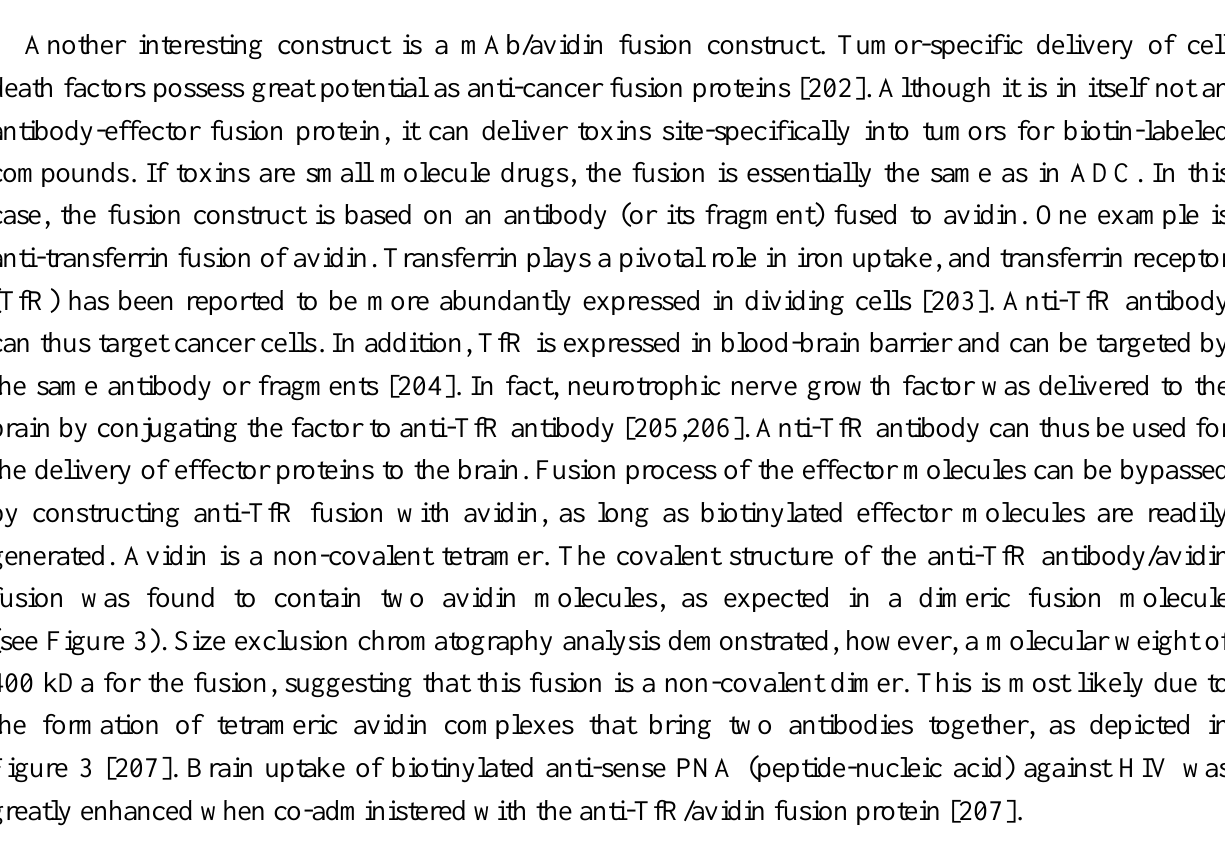
Figure 3. Illustration of a tetrameric fusion complex (anti-transferrin receptor